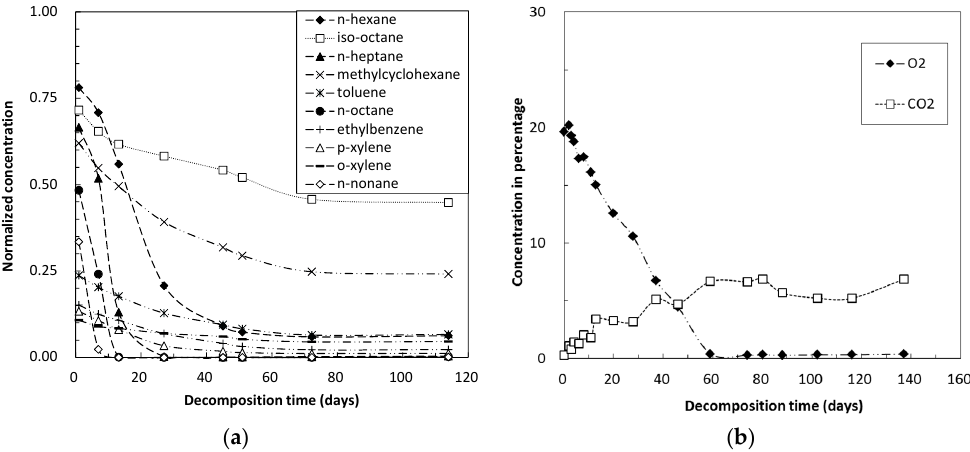
Figure 2. Concentrations over time of ( a ) organic and ( b ) inorganic gases during decomposition tests in surface soil.